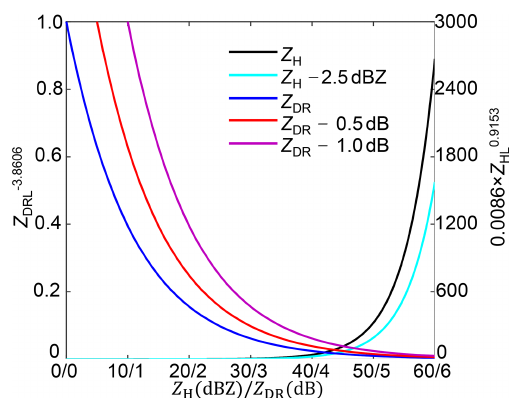
Figure 23. The contribution of Z H -related and Z DR -related terms in the R ( Z H , Z DR ) relationship with different Z H and Z DR biases. The R ( Z H , Z DR ) relationship is detailed in Eq. (12c). Z HL and Z DRL refer to Z H and Z DR at a linear